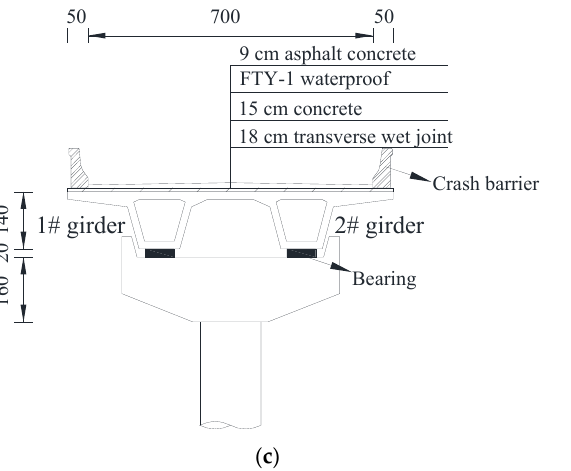
Figure 1. Details of the whole bridge layout (Unit: cm). ( a ) Elevation arrangement; ( b ) Plane layout; ( c ) Cross-sectional layout.